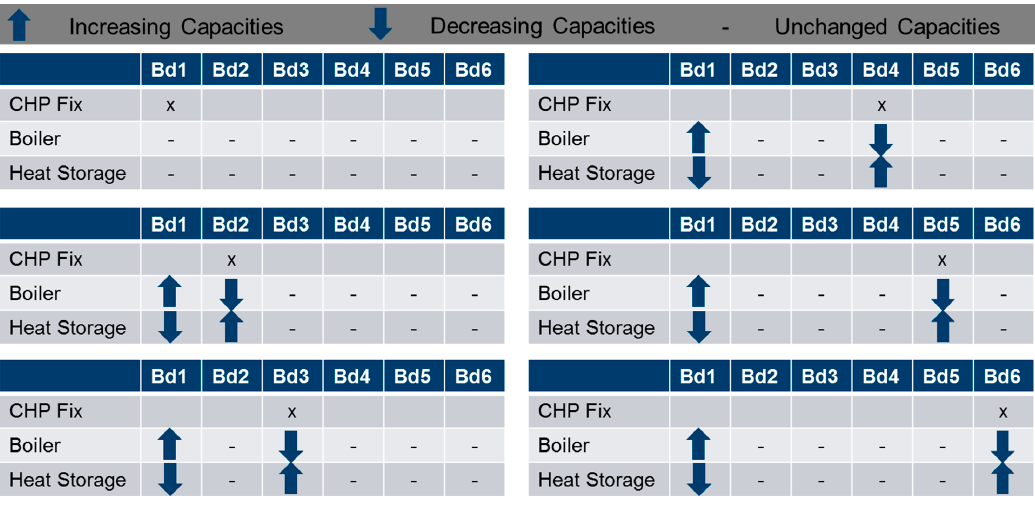
Figure 10. Changing capacities based on fixed CHP location.